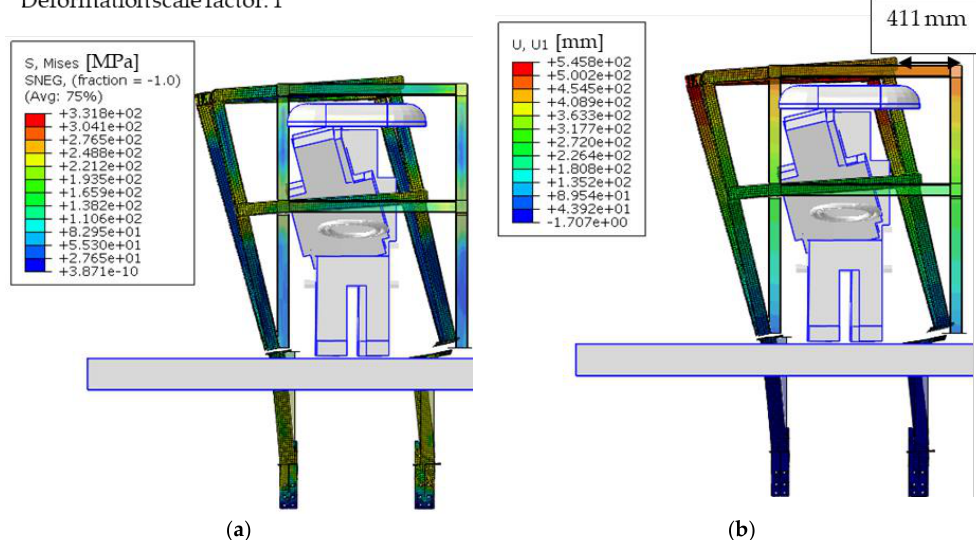
Figure 12. Side loading front view of TOPS and deflection limiting volume: ( a ) contour plot of Von Mises stress (expressed in MPa); ( b ) displacement contour plot (expressed in mm) attained at the maximum required energy.